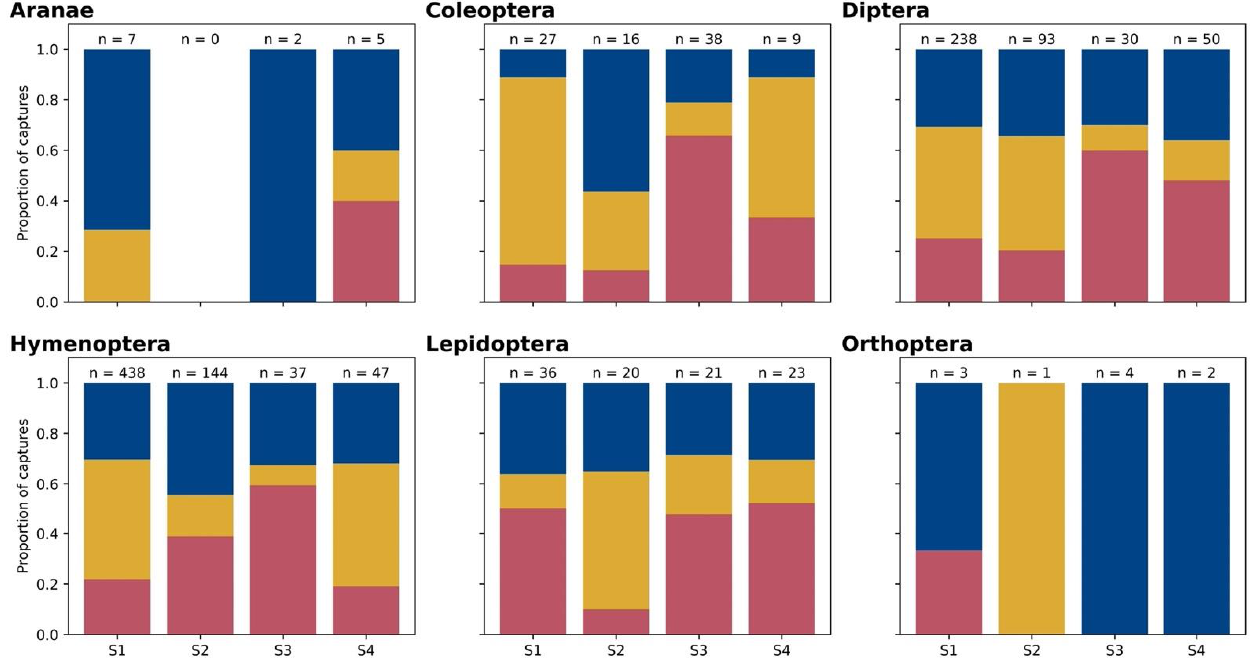
Figure 2. Proportion of insects captured at each one of the four sites contained within the two study locations considered in this study: remnant native habitat of Location 1 (Bars S1 and S2), and introduced garden plants habitat of residential locations, Location 2 (Bars S3 and S4), sampled at the three different times: early in the season (red bars), mid-season (yellow bars), and late in the season (blue bars) during the Australian summer of 2016–2017. Panels represent the various orders of insects captured as indicated by the respective labels. Numbers at the top of each bar indicate the total number of individuals captured at each site. Sampling details are provided in the sub-section Data collection under the section Materials and Methods (see also supplementary Table S1).